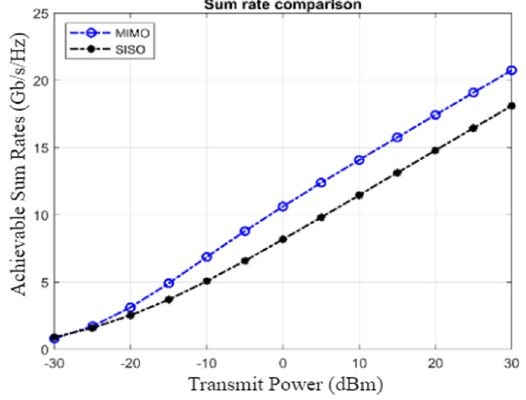
Figure 8. Sum rates vs. transmit power.